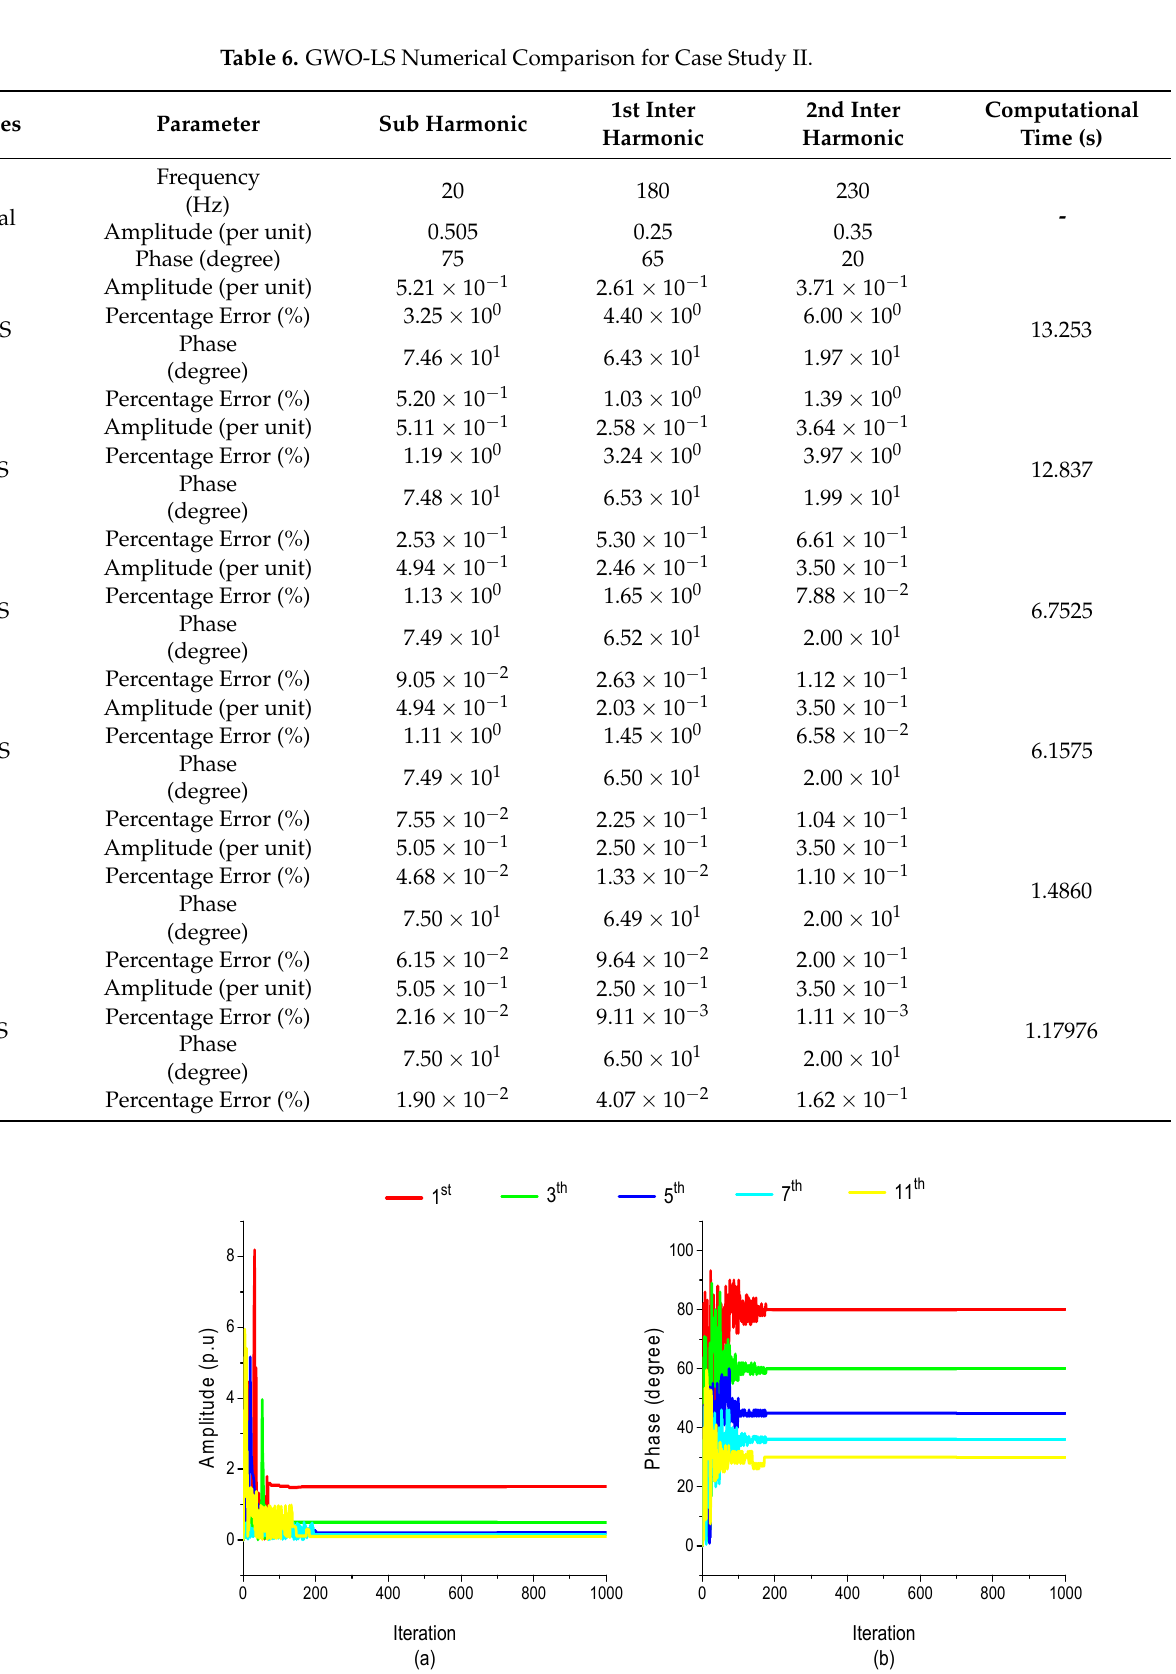
Table 5. The percentage error of GWO-LS for the 1st, 3rd, 5th, 7th, and 11th harmonic phase are 7.70 × 10 (cid:2879)(cid:2871) , 1.48 × 10 (cid:2879)(cid:2870) , 6.60 × 10 (cid:2879)(cid:2870) , 2.7 × 10 (cid:2879)(cid:2871) , and 8.33 × 10 −2 , respectively. The minimum error is achieved for 1st, 3rd, 5th, 7th, and 11th using GWO-LS in compar- ison with other harmonic estimators. The comparison between the proposed and litera- ture harmonic estimator in case of harmonics amplitude and phase can be better seen in Figures 9 and 10. It is clear from both the Figures that the proposed GWO-LS estimator has the least percentage error for all the harmonic contents. The behavior of the proposed